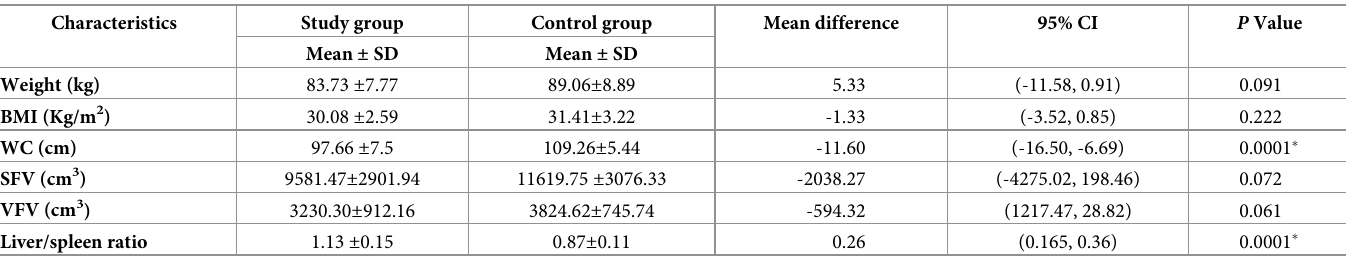
Table 2. Weight, body mass index, waist circumference, subcutaneous fat volume, visceral fat volume, and Liver/spleen ratio post-intervention. Characteristics